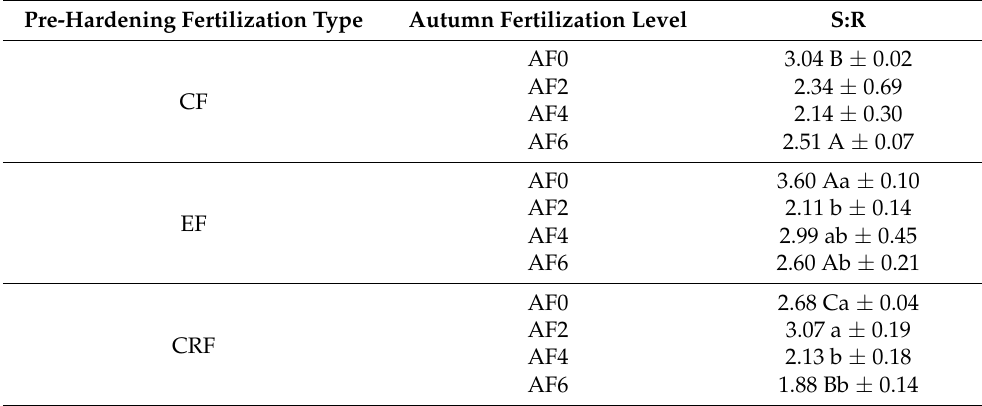
Table 3. Effects of pre-hardening fertilization type and autumn fertilization level on shoot-to-root ratio (S:R) (mean ± SE) of Pinus koraiensis seedlings at the end of experiment. Different capital letters indicate a significant effect of S:R among pre-hardening fertilization types ( p < 0.05). Different lowercase letters indicate significant differences in S:R among autumn fertilization levels ( p < 0.05). Means were compared using Duncan’s